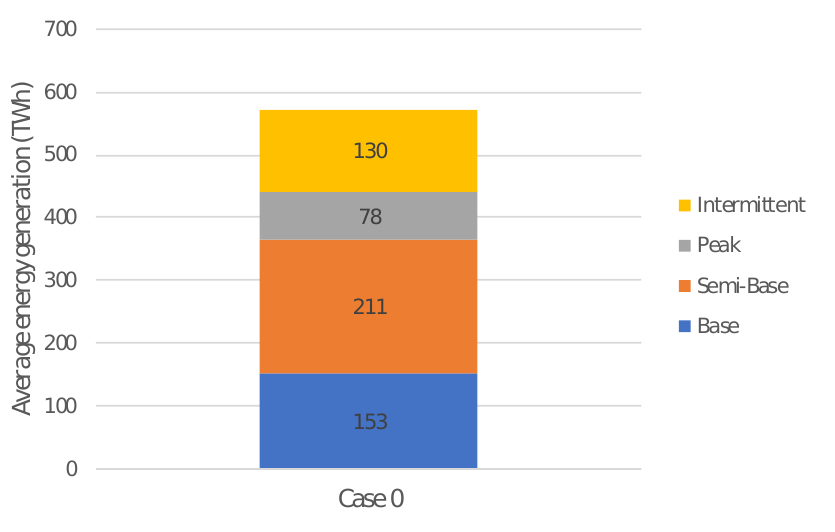
Figure 2. Average generation breakdown for Case study 0.